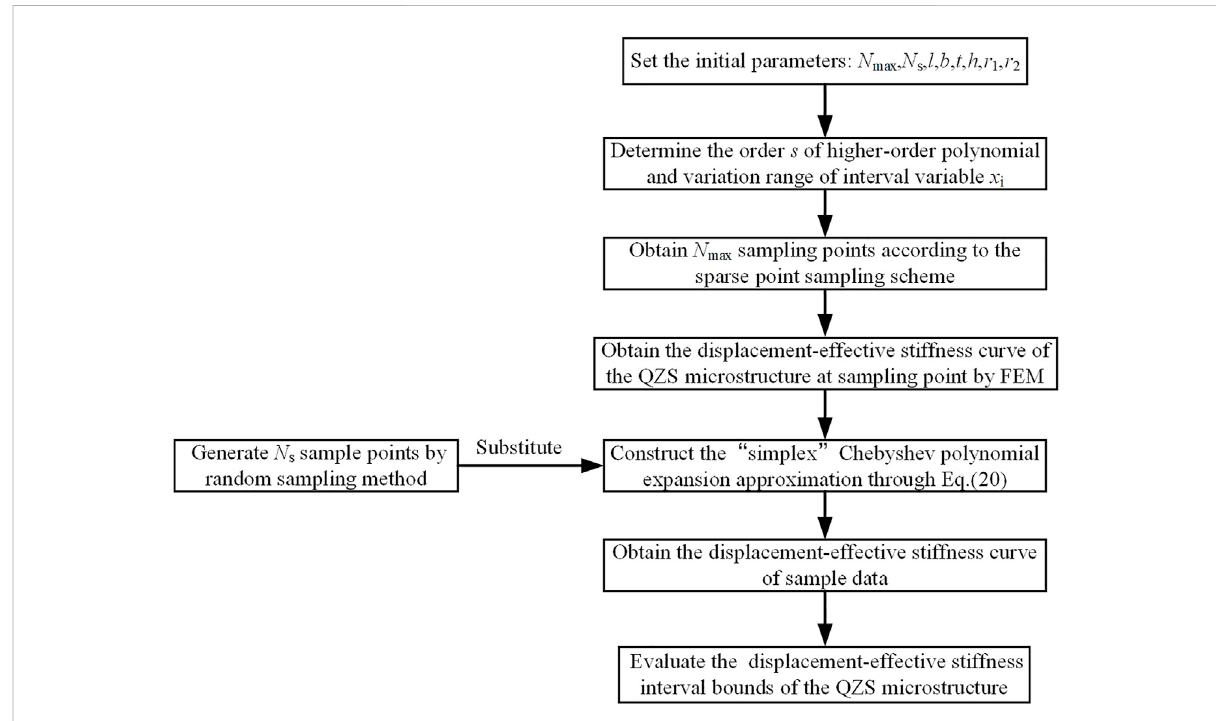
FIGURE 2 Flowchart of the HOSPSCPE method for the QZS microstructure analysis with uncertainty.